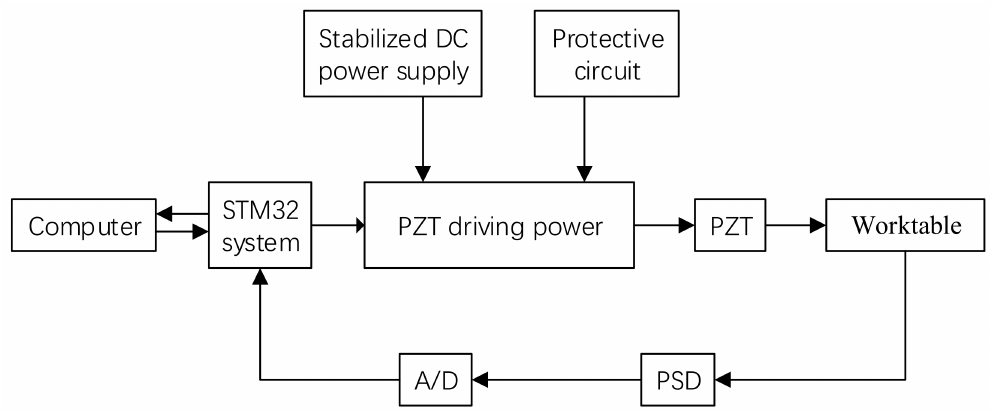
Figure 1. Diagram of precision positioning system.